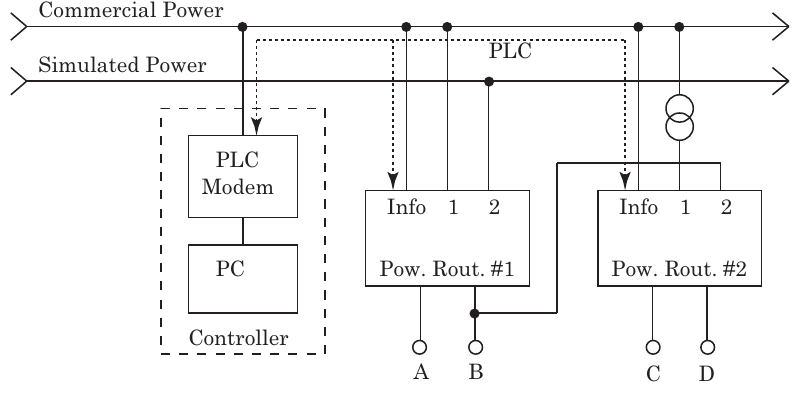
Figure 9. Schematic diagram of a system in series connection.